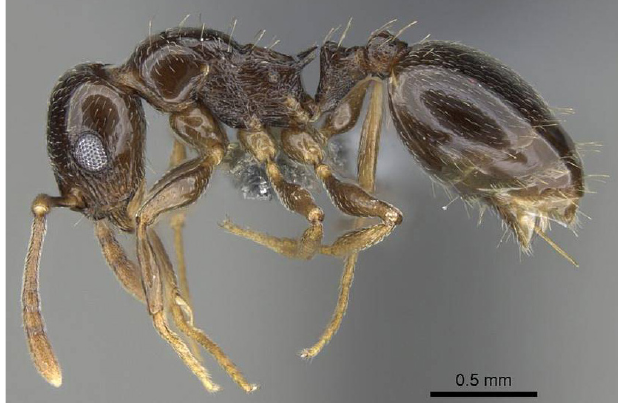
Fig 8 . Temnothorax ansei sp.n. intermorphic individual in lateral view. Photo credit: Michele Esposito, from www.AntWeb.org, CASENT0919826_P, published with permission.